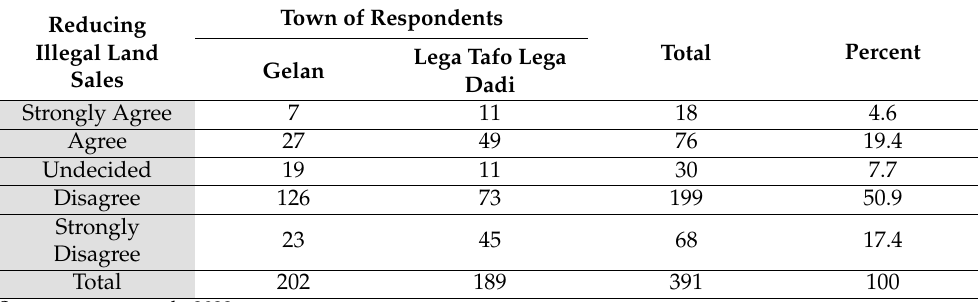
Table 5. The response rates of respondents on illegal land sales. Reducing Illegal Land